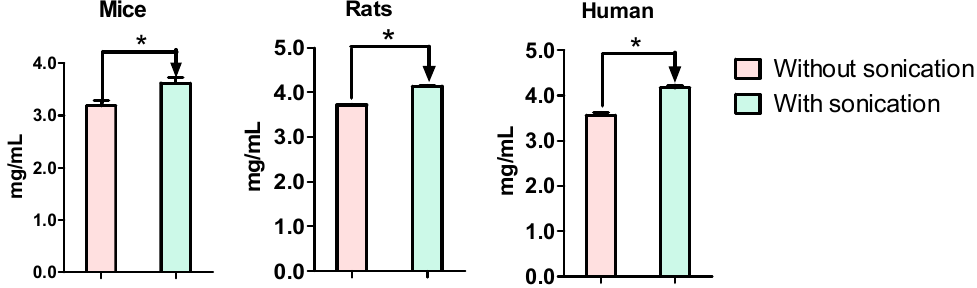
Figure 2. Total protein concentrations were prepared from feces with or without sonication. Feces were homogenized in 50 mM KPI buffer (pH 7.4) with vigorous vortex or sonication (550 w sonicator), followed by centrifugation at 9000 × g at 4 °C for 15 min (n = 3, * p < 0.05, t -test).